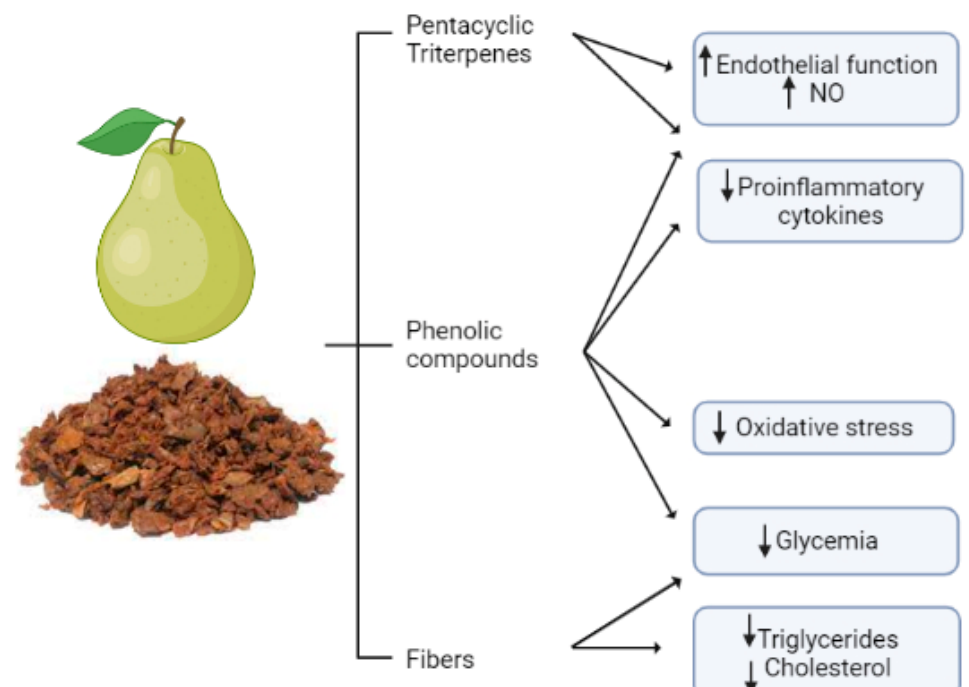
Figure 3. Pear pomace classes of bioactive compounds and their cardio- and vasculoprotective actions. Pear pomace contains fibers that mainly provide cholesterol- and triglyceride-lowering effects, but it also contains bioactive compounds, such as phenols and triterpenes, that provide multiple effects positively affecting the cardiovascular system, such as improvement in endothelial function, reduction in proinflammatory cytokines and oxidative stress, and a hypoglycemic effect. Overall, thanks to its composition, pear pomace exerts pleiotropic cardio- and vasculoprotective effect by targeting multiple signaling pathways and risk factors. The figure is original and created with BioRender.com.